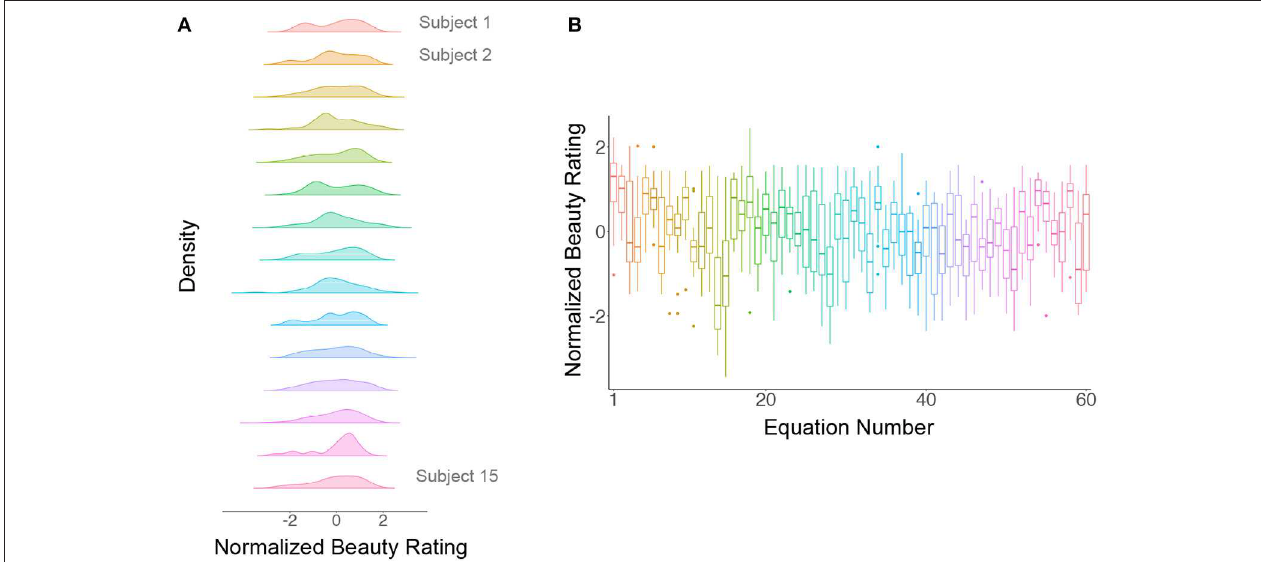
FIGURE 1 | (A) Normalized ratings against subjects. The distribution of the normalized ratings for each subject is approximately Gaussian with a mean of 0 and a standard deviation of 1. (B) Normalized ratings against equations. The ratings for each equation are represented by a box plot; the horizontal line within each box plot represents the median of the ratings and the vertical lines represents the first and the last quartile of the ratings, respectively, while the box itself represents the middle 50% of the ratings. Dots represent outlier ratings.